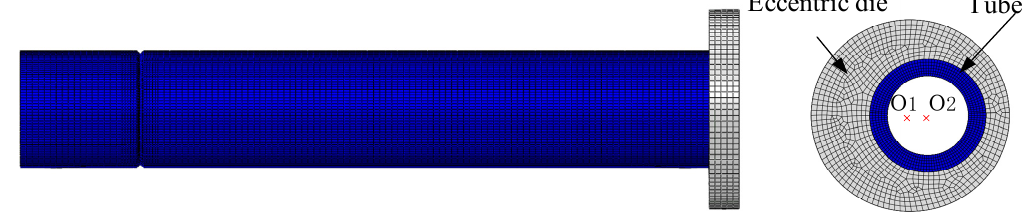
Figure 8. Assembly of tubing and eccentric wheel.